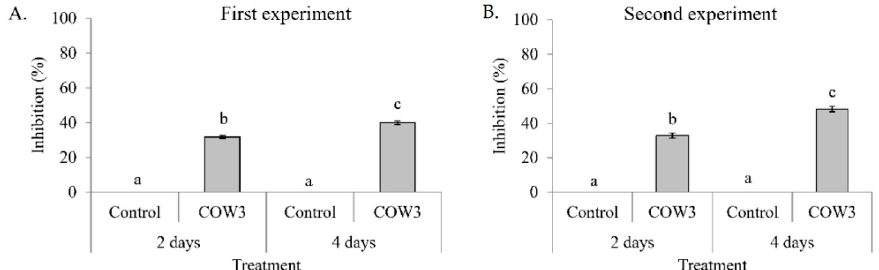
Figure 7. In vitro antagonistic e ff ect of COW3 on P. myriotylum . Co-culturing of bananamide D-G-producing strains COW3, with P. myriotylum CMR1. ( A ) Percentage inhibition of CMR1 by COW3. Representative pictures were taken after two and four days, respectively. The experiment was conducted with 6 replicates and was repeated in time. The two experiments are shown. Vertical lines indicate standard deviations. Di ff erent letters (a, b, c) indicate statistically significant di ff erences among di ff erent treatments (Anova followed by a Tukey’s tests: n = 6; α = 0.05), D: bananamide D; E: bananamide E; F: bananamide F; G: bananamide G. ( B ) Representative pictures showing the inhibition of P. myriotylum CMR1 by